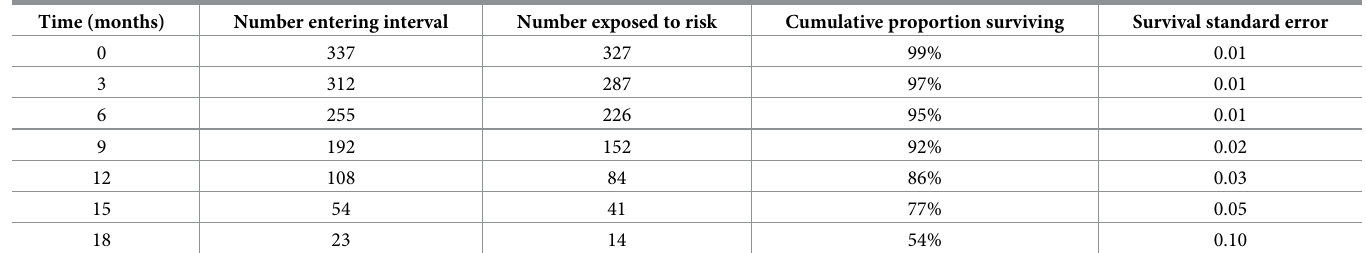
Table 2. Life table for the TB patients in Liberian (n = 337).